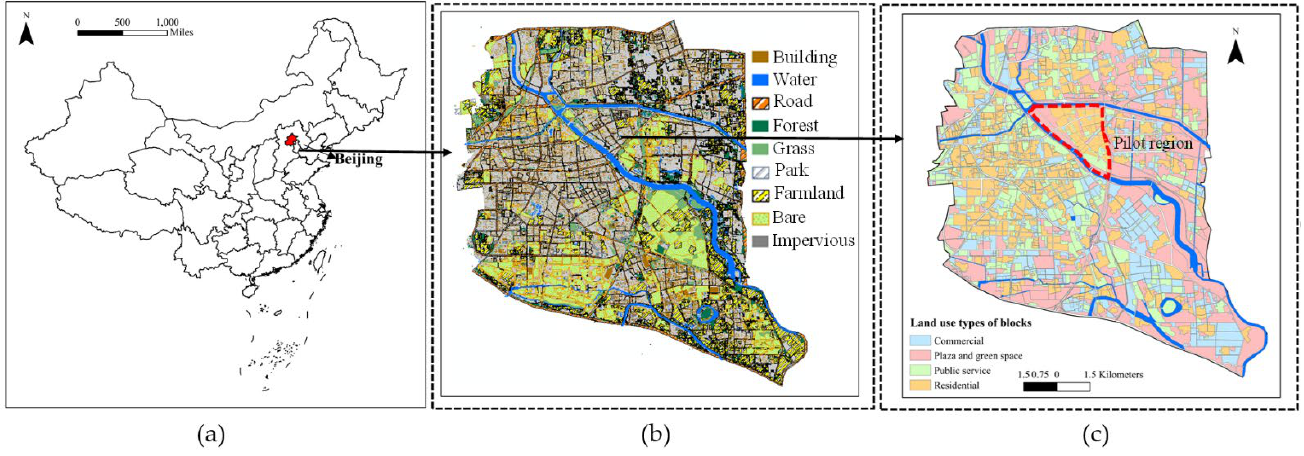
Figure 1. Study area for the ARVCR target in the built-up area of the Beijing urban sub-center. ( a )